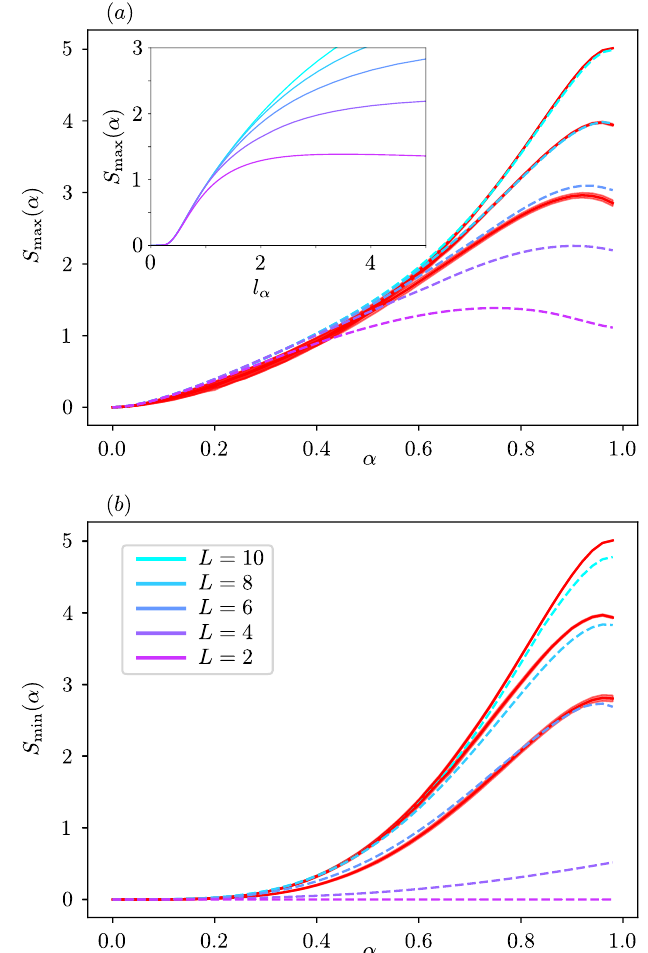
Figure 4: (a): The maximum entropy for different α and the prediction of the random sector approach (red solid lines for L = 6,8,10). The maxima for the different initial conditions were obtained by time evolution up to t = 100. Inset: The same data, but plotted against the localization length l α . (b): The minimum entropy after the first maximum at t = π . The dashed lines show predictions from the random sector approach. The red shaded areas indicate one standard deviation in the distribution of the random